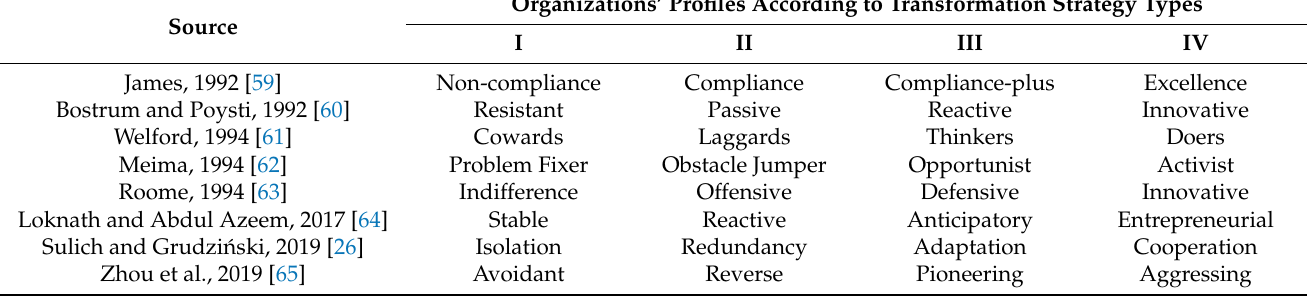
Table 12. The energy sector strategy